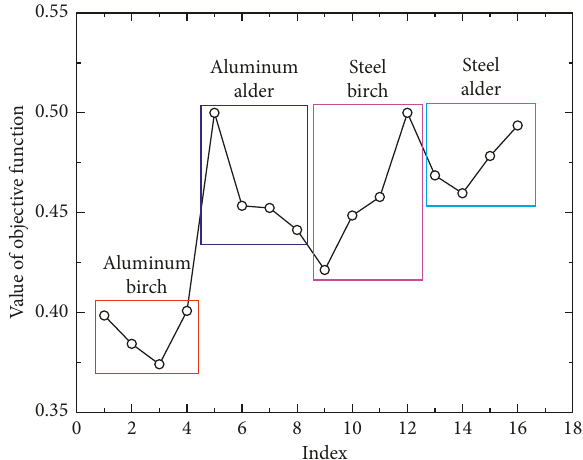
Figure 20: Optimal objective values under different design